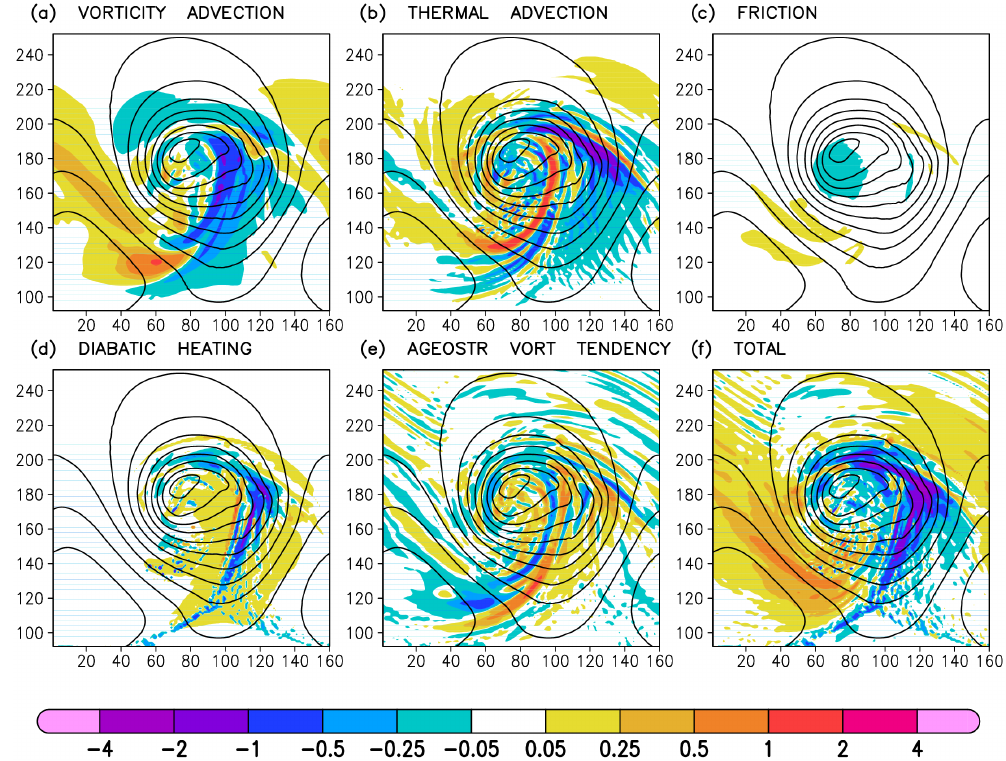
Figure 5. Vertical motions induced by individual forcing terms at level 700hPa at time 118h. (a) ω V , (b) ω T , (c) ω F , (d) ω Q , (e) ω A and (f) ω TOT . Unit is Pas − 1 and contour lines show 900hPa geopotential height with 50m